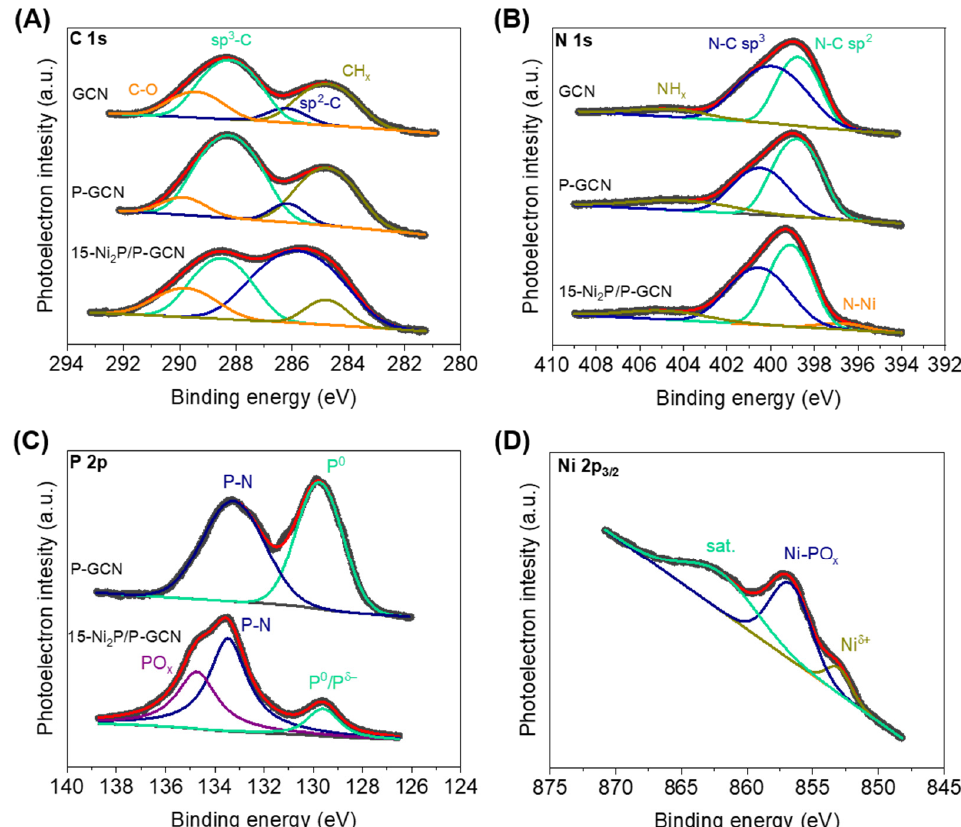
Figure 3. Typical XPS spectra of ( A ) C 1s and ( B ) N 1s for GCN, P-GCN and 15-Ni 2 P/P-GCN. ( C ) P 2p XPS spectra of P-GCN and 15-Ni 2 P/P-GCN and ( D ) Ni 2p 3/2 XPS spectrum of 15-Ni 2 P/P-GCN.